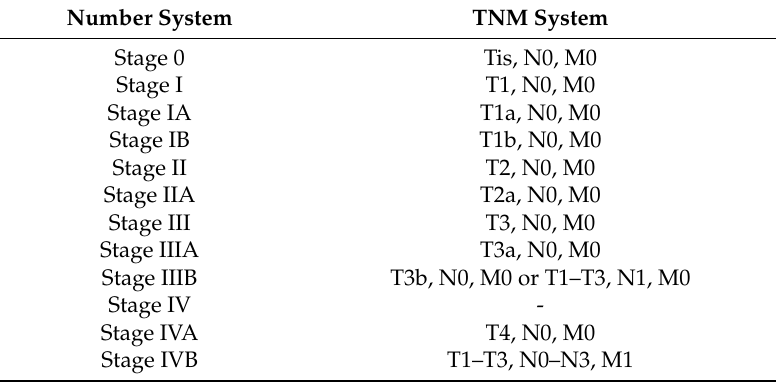
Figure 1. Graphs plotted between 5-year survival rates versus stages of cancers. It is clear that at the initial stage of cancer development, patients have significantly larger chances of being cured. ( a ) Ovarian stromal tumor [5], ( b ) Cervical cancer [6]. Table 1. The relationship between the number system and TNM system of cancer for cervical cancer [7].